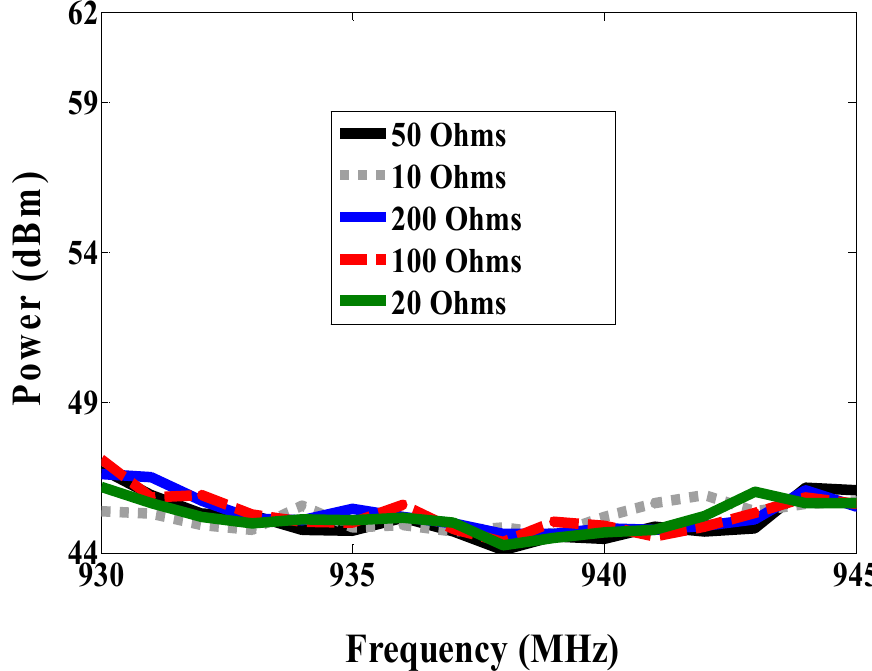
Figure 15. Measured minimum power required to activate reference node with different resistance (antenna C).